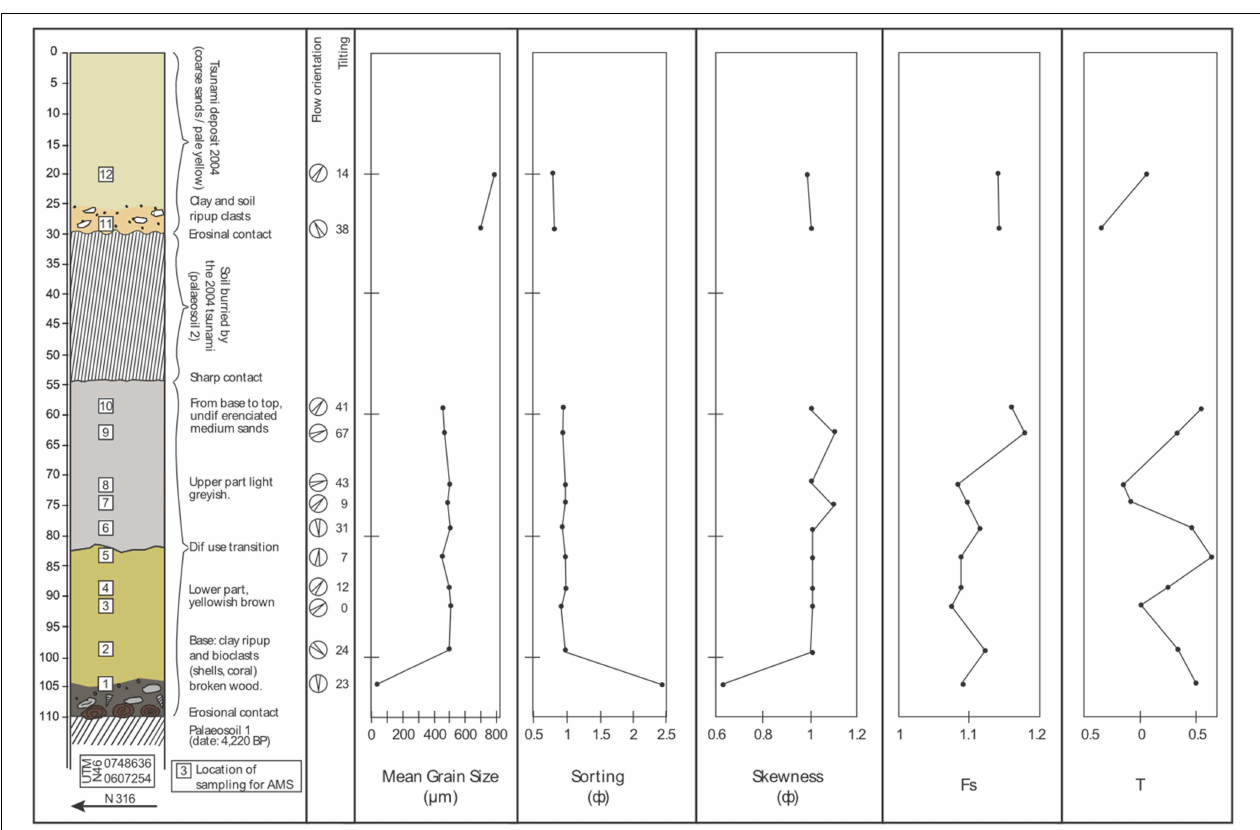
FIGURE 4 | Section description showing the emplacement of sampling